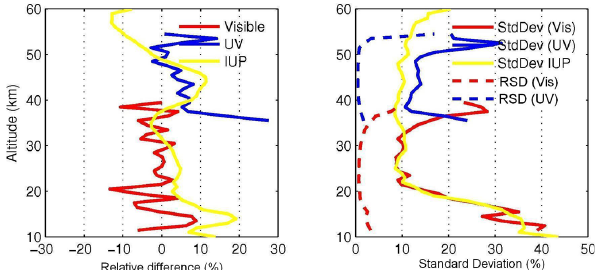
Fig. 14. Summary plot of the relative difference (percent) for all retrieved ozone profiles used in this study with SAGE II (left panel). The right panel shows the standard deviations, and the RSD.